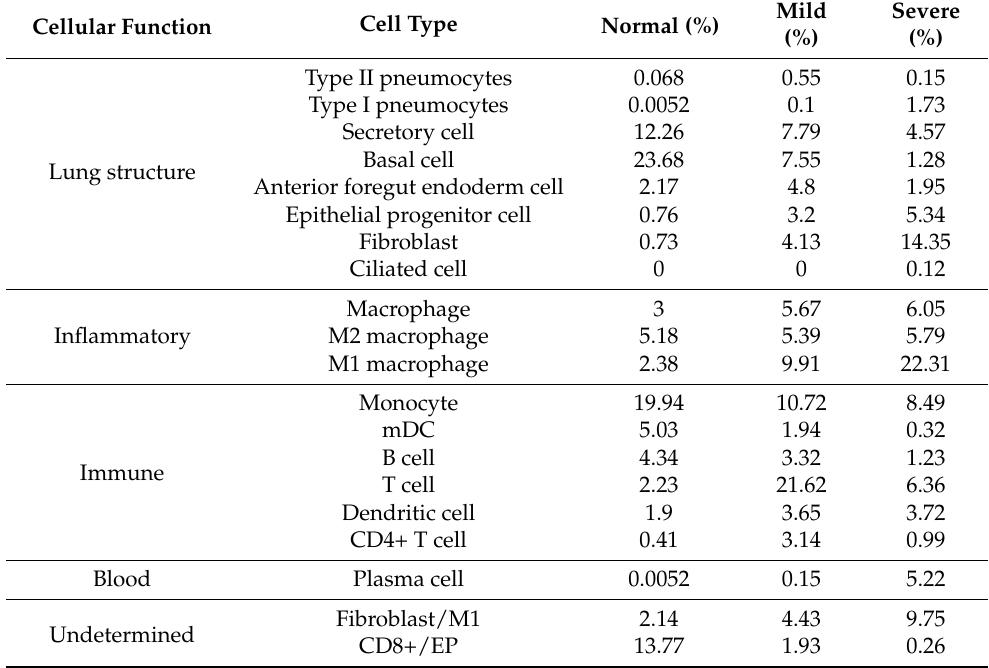
Table 3. Percentage of a cell type assigned to cells in N, M, and S groups. Cellular